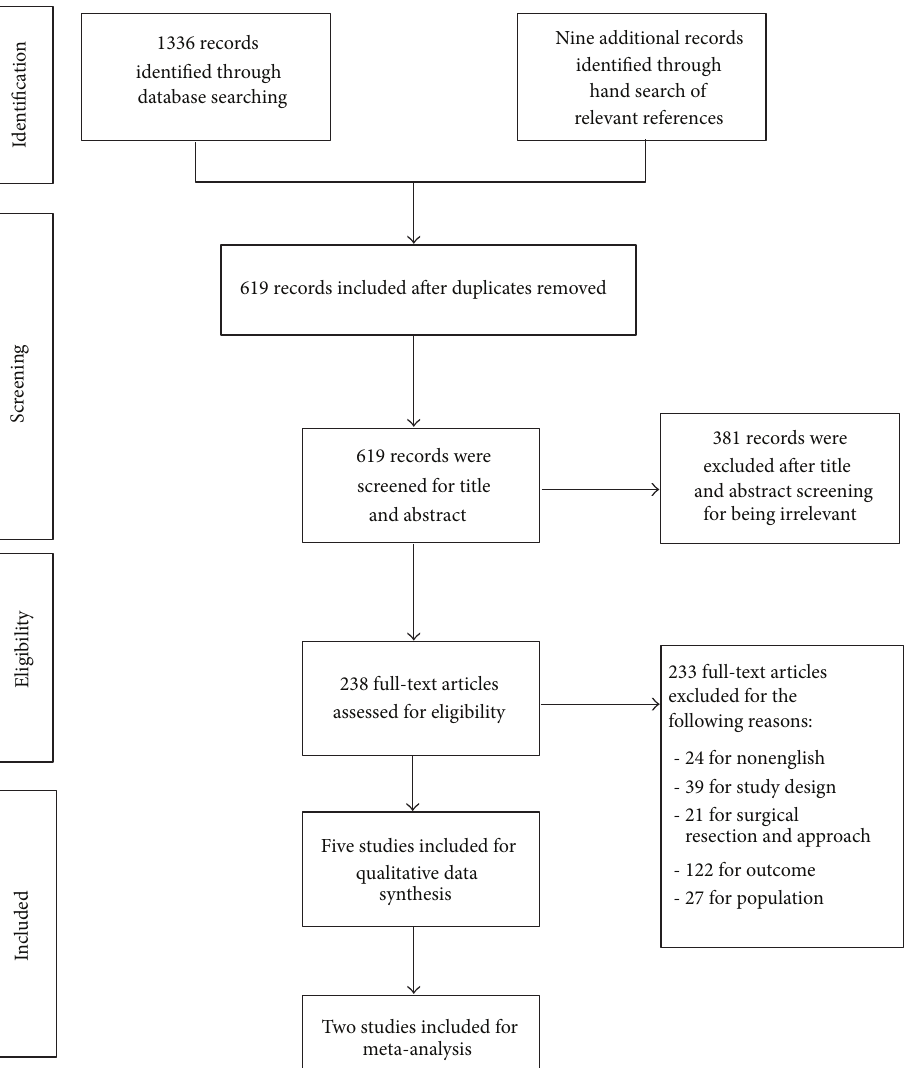
Figure 1: Flow chart summarizing the results of the screening process and study selection as per the PRISMA guideline.